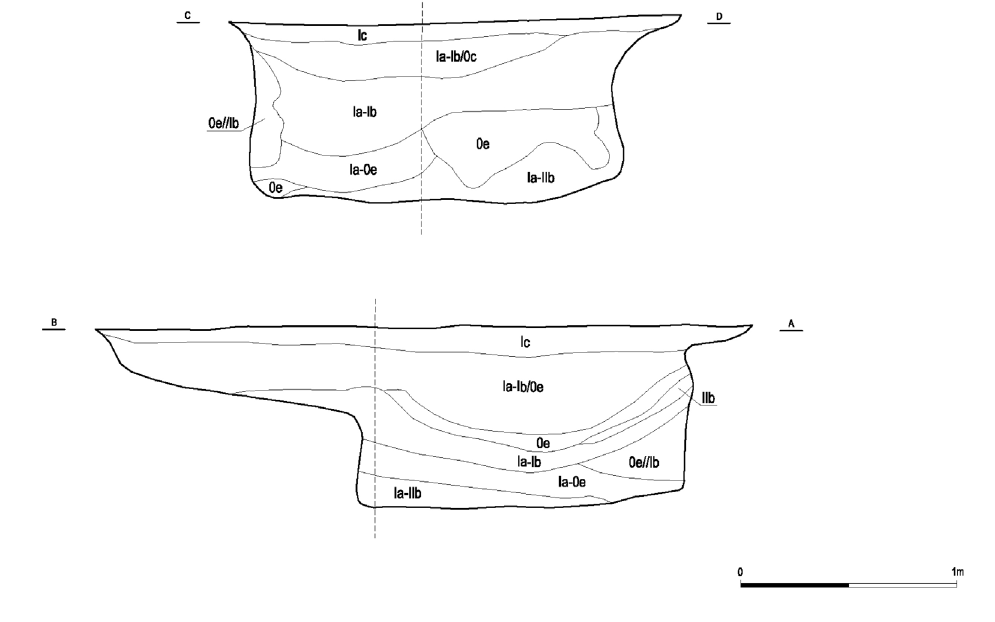
Figure 6: Cross-section of feature 100, Targowisko site